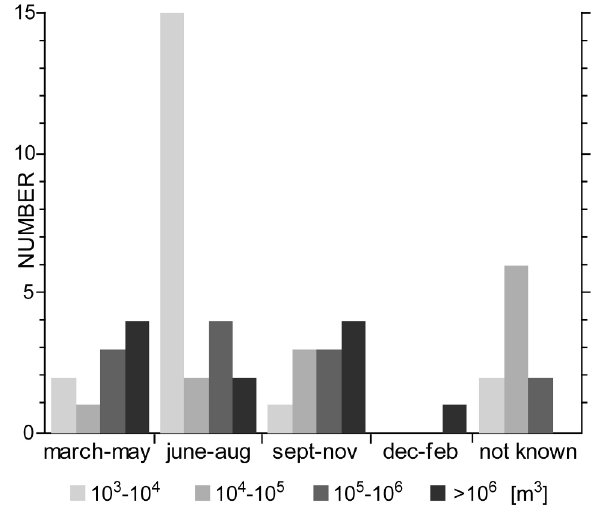
Fig. 5. Seasonal distribution of the slope failure events, divided into the four volume classes.